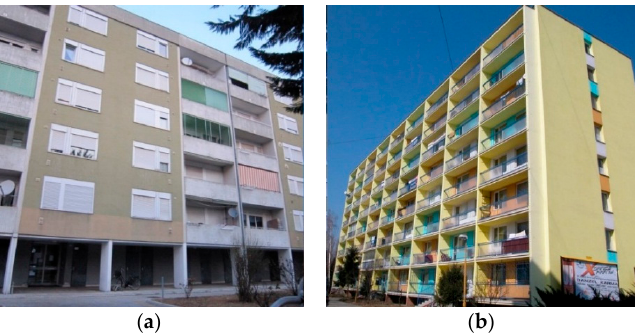
Figure 3. Buildings from the seventies with similar typology: ( a ) In Trento (Italy); ( b ) In Kosize (Slovak Republic).